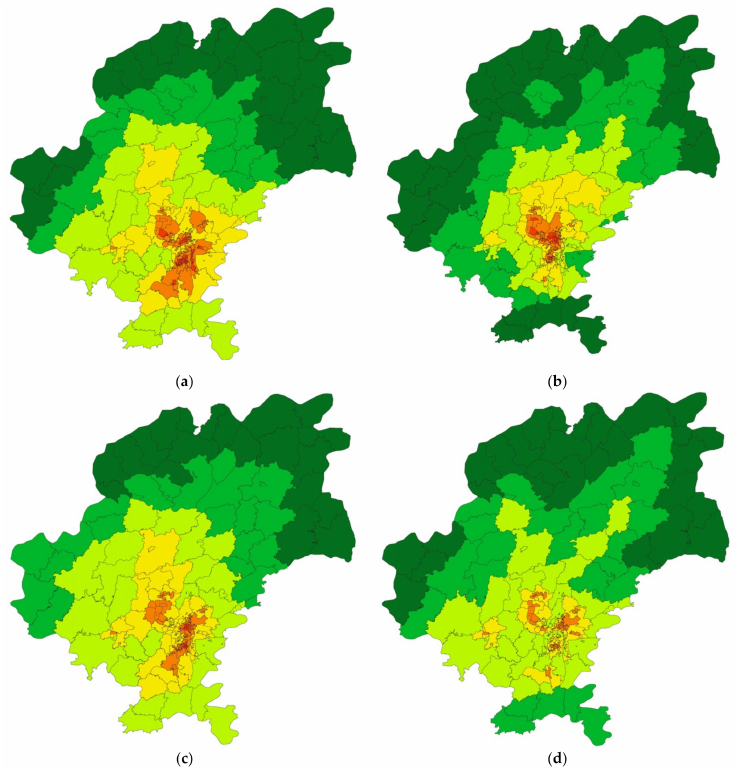
Figure 7. Visualization map of urban regional vehicle density in areas of Guiyang. ( a ) Traffic conditions at 8 o’clock. ( b ) Traffic conditions at 12 o’clock. ( c ) Traffic conditions at 18 o’clock. ( d ) Traffic conditions at 22